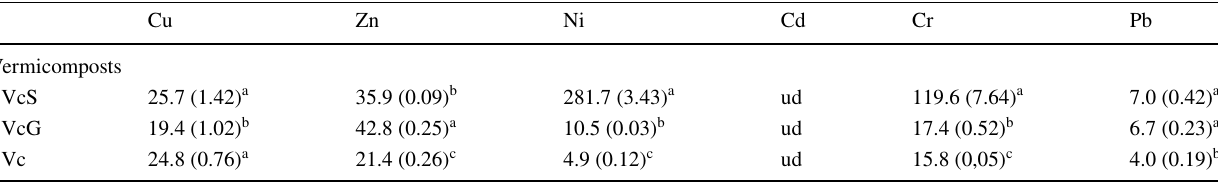
Table 3 Mean metal concentrations (n = 6; standard error) in the vermicomposts at the end of vermicomposting with cattle manure with steatite powder (VcS), or gneiss powder (VcG), or without rock powder (Vc)